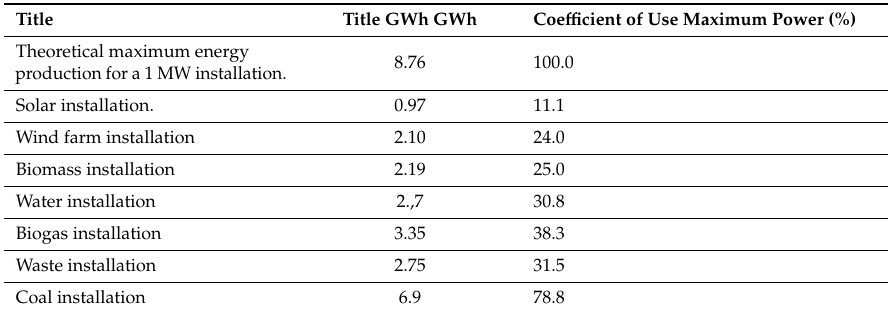
Table 3. Maximum power consumption in various installations of substitutes for conventional energy